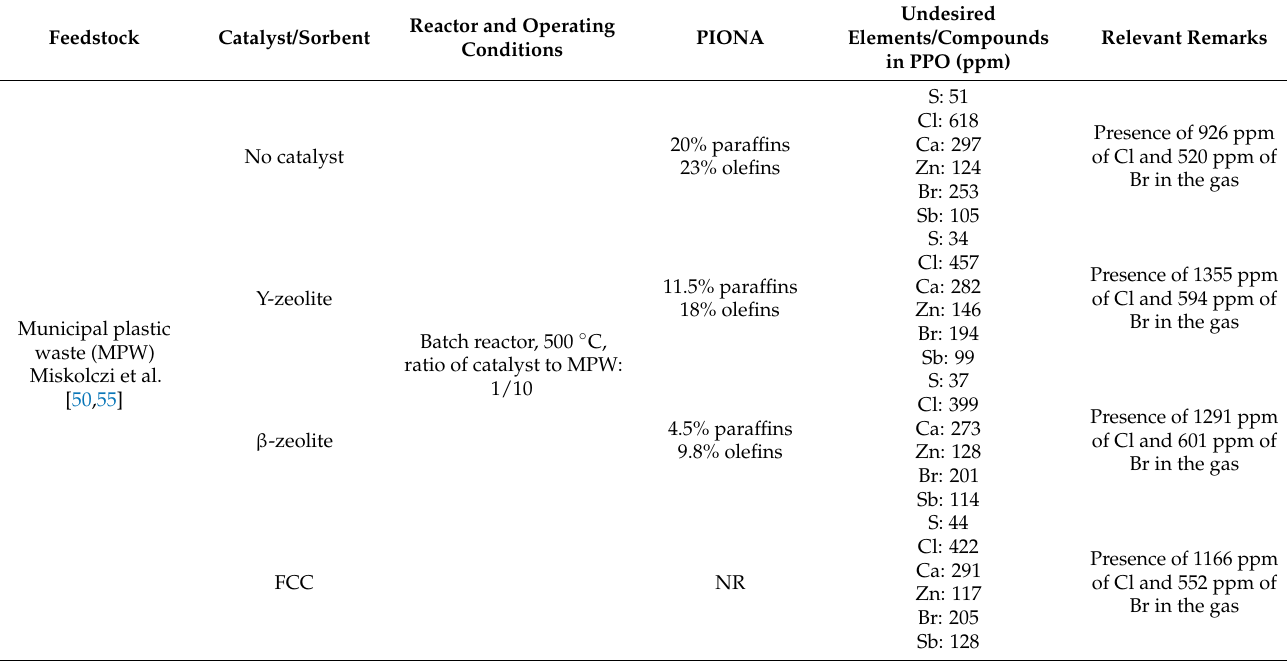
Table 5. Effect of catalyst on pyrolysis products and contaminants. Concentrations are as specified in the respective